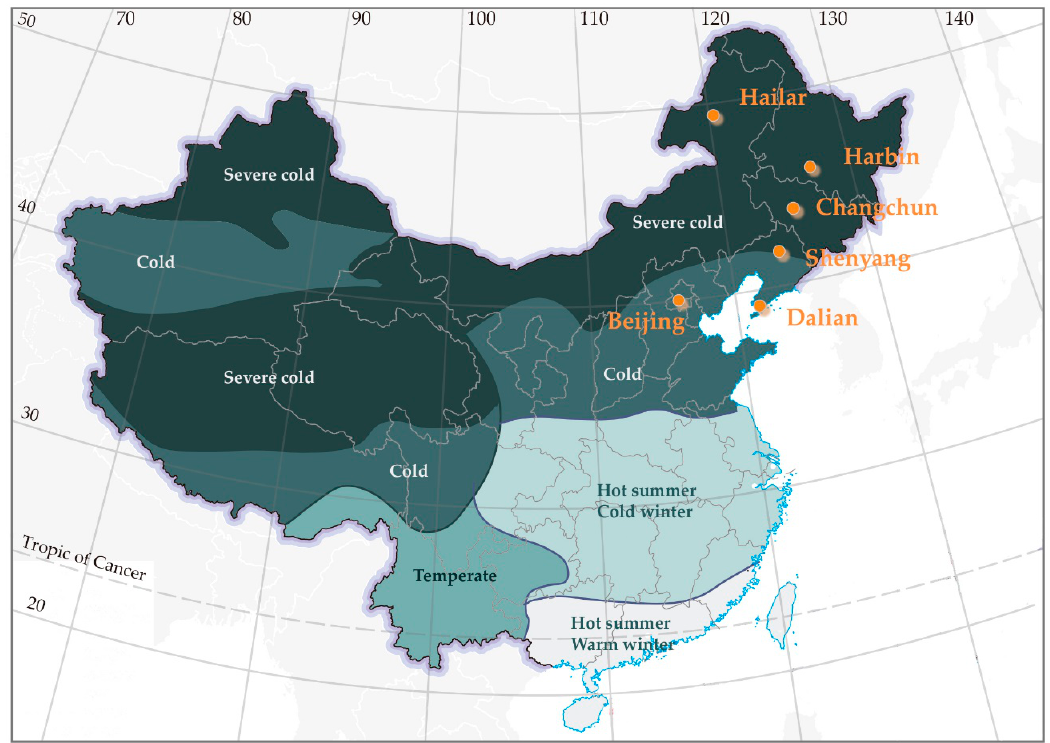
Figure 4. Locations of the six case study cities in Mainland of China. (Data source: Code for thermal design of civil buildings (GB 50176-2016); drawn by the authors). Table 3. Six case study cities by climate regions in China.